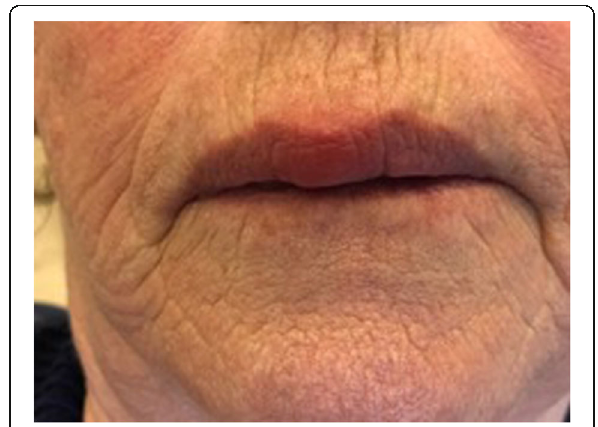
Fig. 1 Swelling of the medial portion of the upper lip